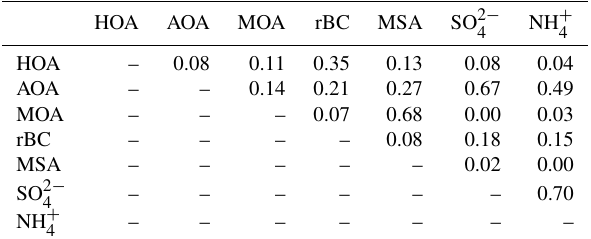
Table 2. R 2 correlations between PMF factors and tracers (rBC, MSA, SO 2 − and NH + 4 4